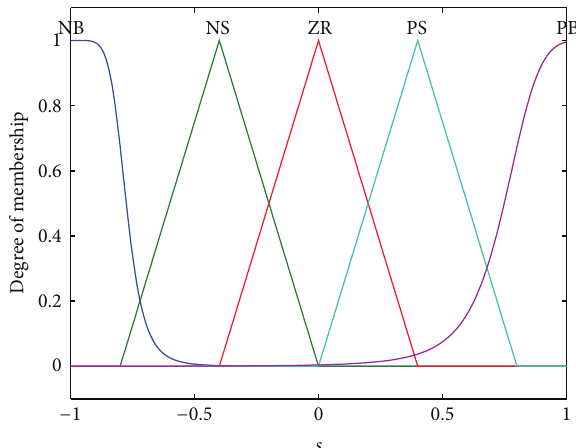
Figure 15: Membership function of fuzzy input 𝑠 .